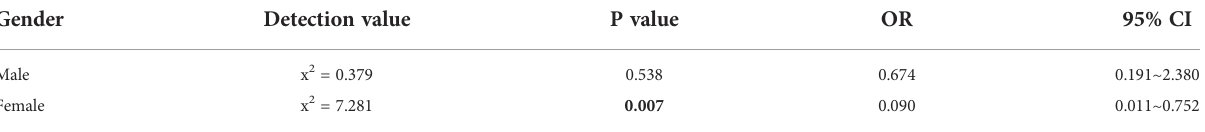
The meaning of the bold values is